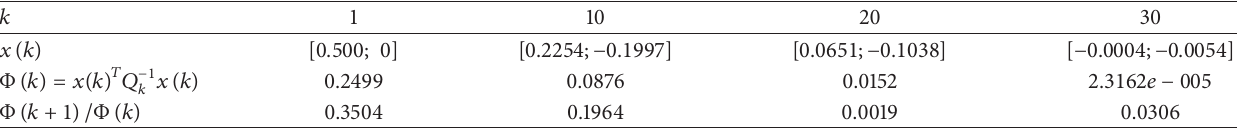
Figure 5: Closed-loop responses for Example 12. Table 2: The convergence